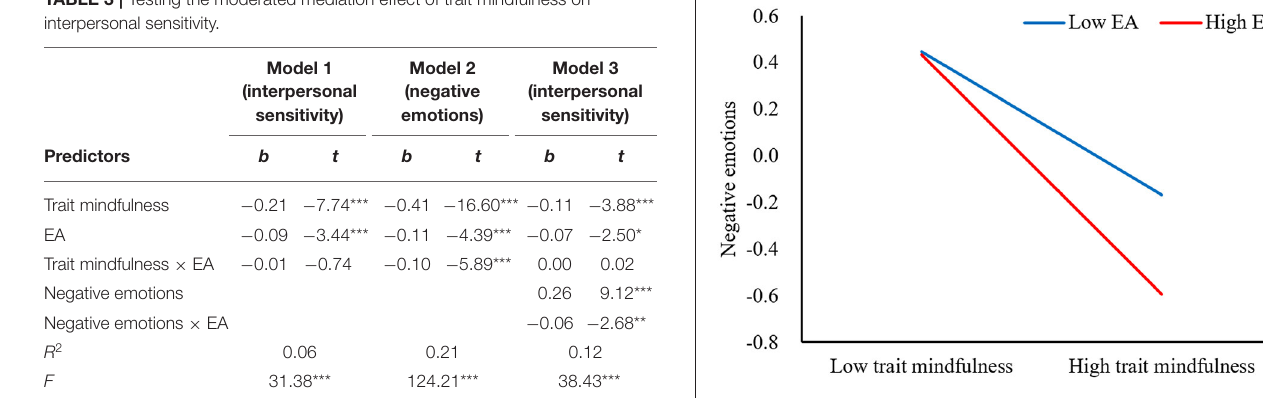
FIGURE 2 | Effects of trait mindfulness and EA on negative emotions. Two levels of EA graphed include one standard deviation above and below the mean, respectively. The graph is for description only. All inferential analyses keep continuous data of trait mindfulness and EA (the same below).